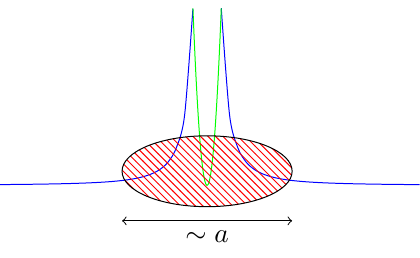
2 of a dimer is localized on a UV length ψ | |